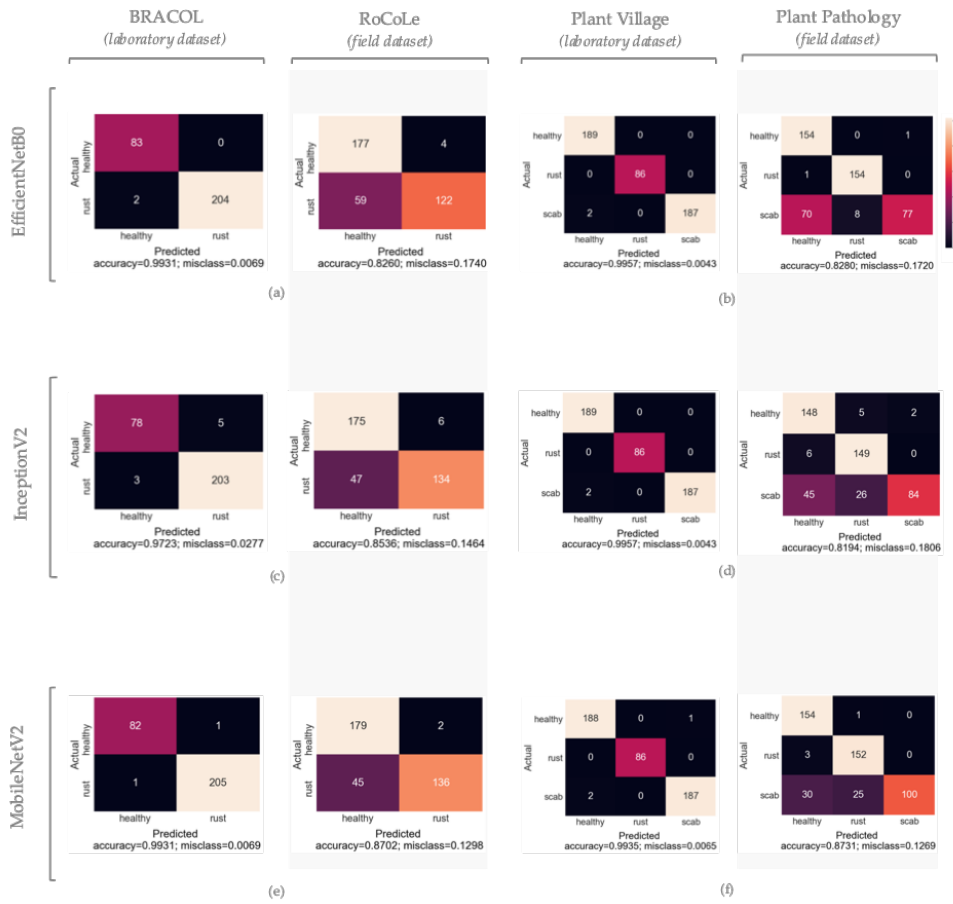
Figure 3. Confusion matrices obtained on test set. The first column contains the results for the binary classification of coffee leaves (BRACOL and RoCoLe datsets), while the second column contains the multiclass classification of apple leaves (Plant Village and Plant Pathology datasets). Each column on the left contains the results obtained via the laboratory dataset, and the right columns contain those obtained using the field dataset. The images ( a , b ) are the scores obtained by EfficientNetB0. The images ( c , d ) are the scores obtained by InceptionV2. The images ( e , f ) are the scores obtained by